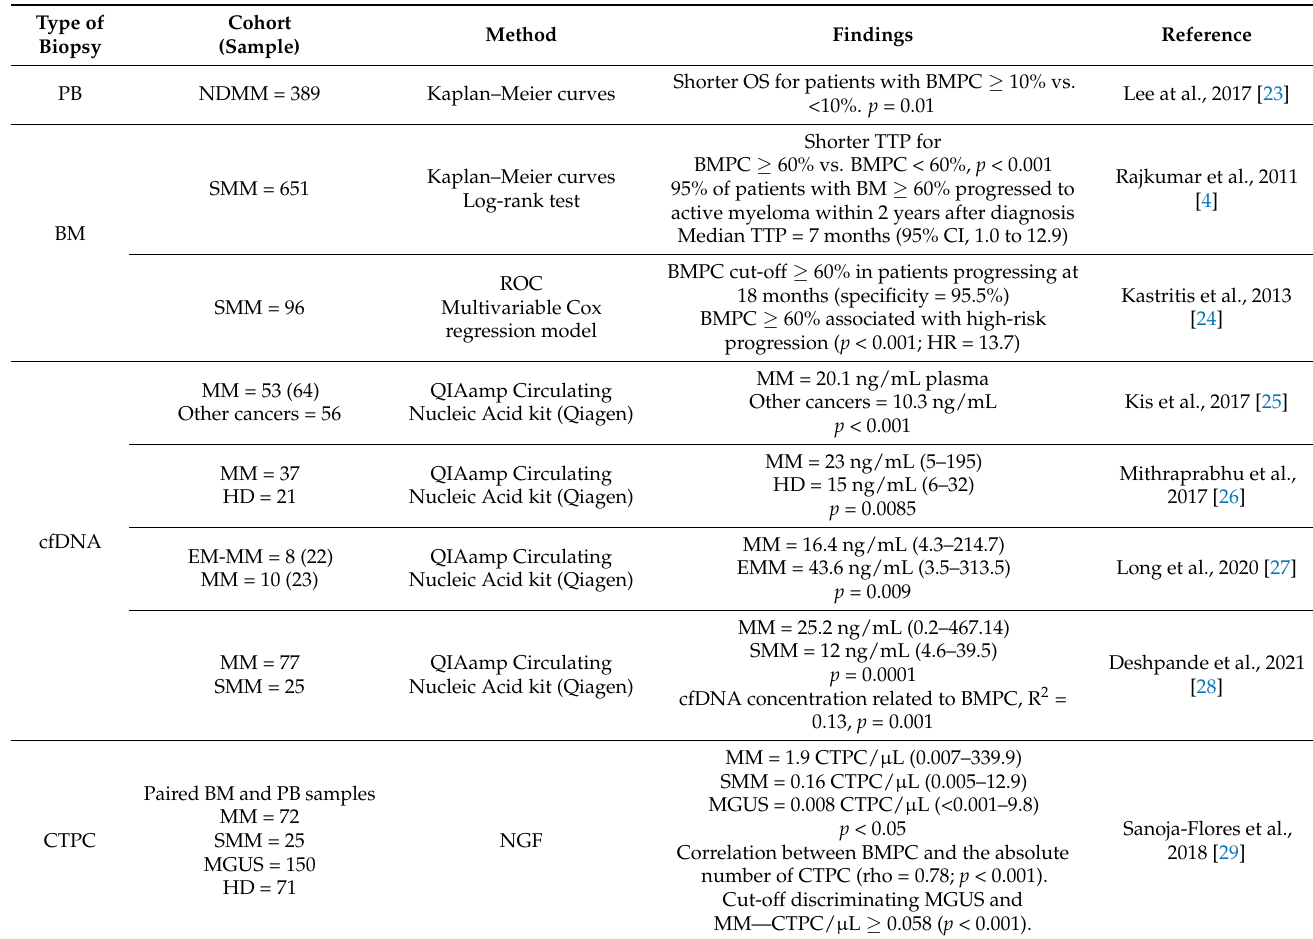
Table 1. Summary of BM and liquid biopsies evidence as diagnosis